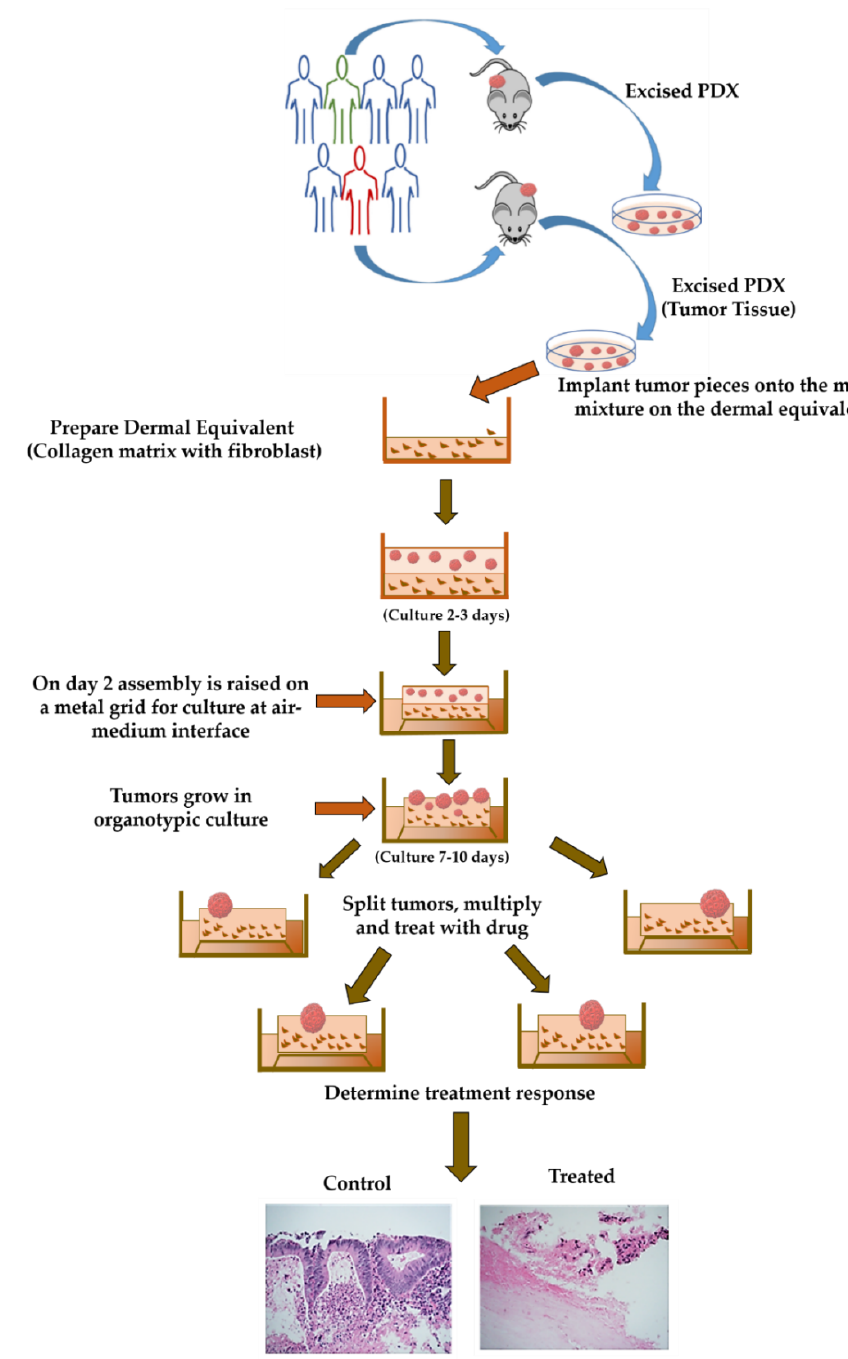
Figure 1. Schematic representation to generate organoid raft cultures from primary CRCs.